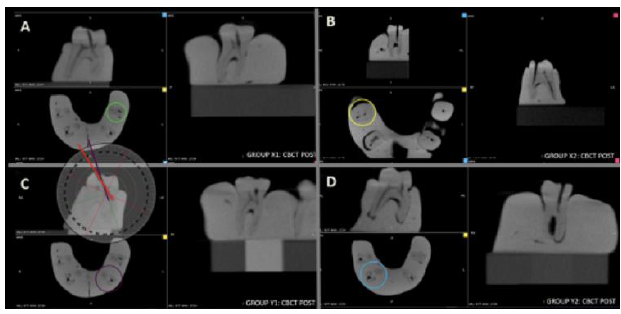
Figure 3. Digital planning of the access cavity using the Navident Software.